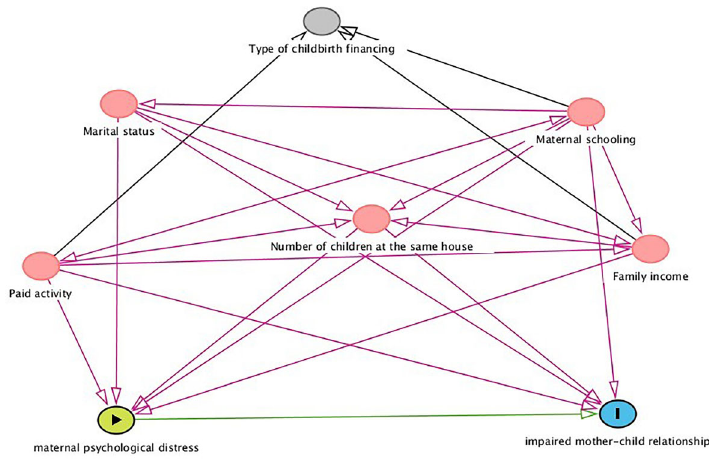
Figure 1. Directed acyclic graph of the association between psychological distress and mother-child relationship. Green: exposure; blue: outcome; pink: ancestor of exposure and outcome; gray: other variable.